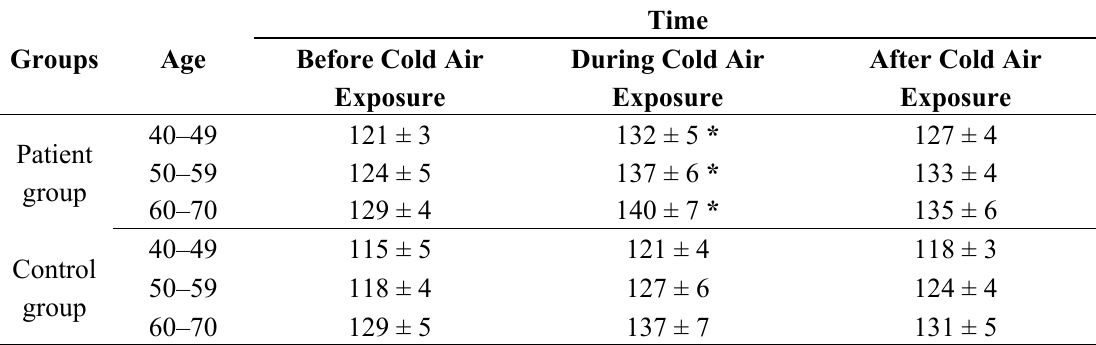
Table 4. Average systolic blood pressure levels in the patient and control groups during a cold air event (mean ± standard deviation, mmHg)